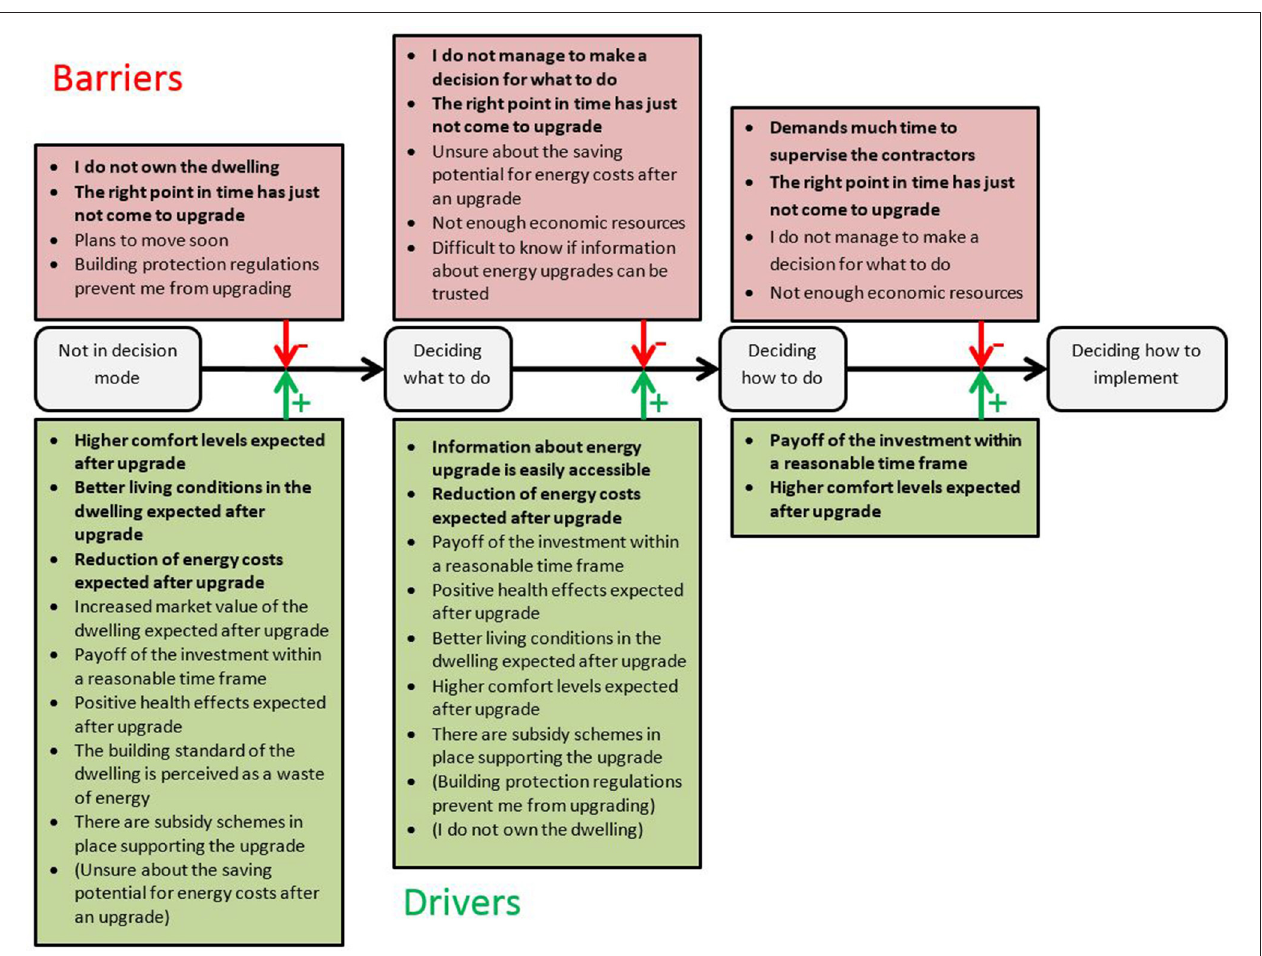
FIGURE 5 | Overview of the structure of barriers and